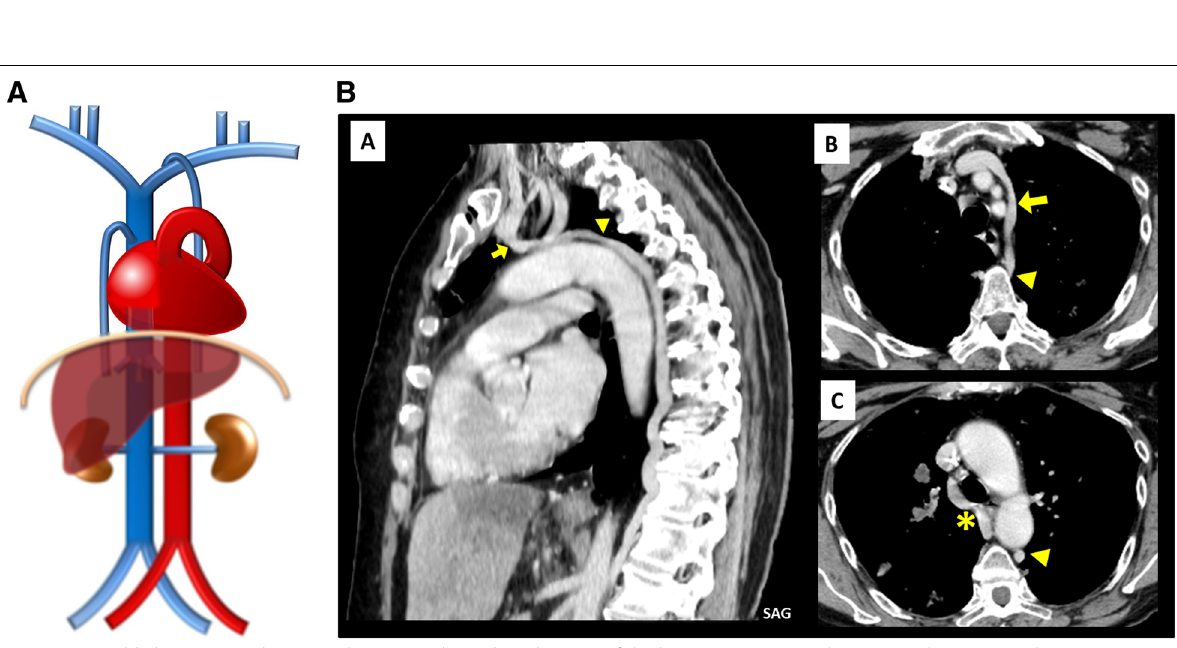
Fig. 17 a Variable hemiazygos drainage schematic. Independent drainage of the hemiazygos vein to the SVC, via the accessory hemiazygos vein → left superior intercostal vein → left brachiocephphalic vein path. b Variable hemiazygos drainage imaging. Contrast-enhanced CT scan showing independent drainage of the hemiazygos vein (triangle) to the left brachiocephphalic vein, via the left superior intercostal vein (arrow), with normal drainage of the azygos vein via the azygos arch (asterisk)